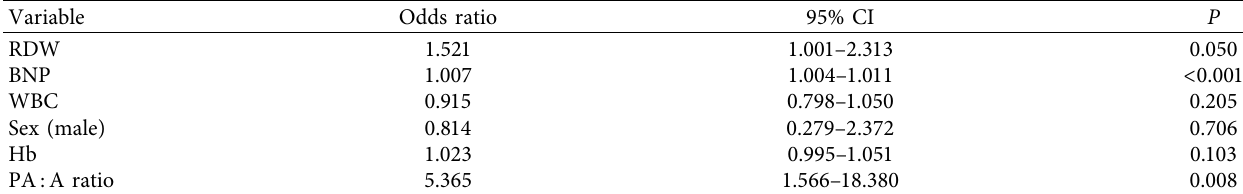
Table 2: Independent risk factors for PH indicated by logistic regression model analysis.